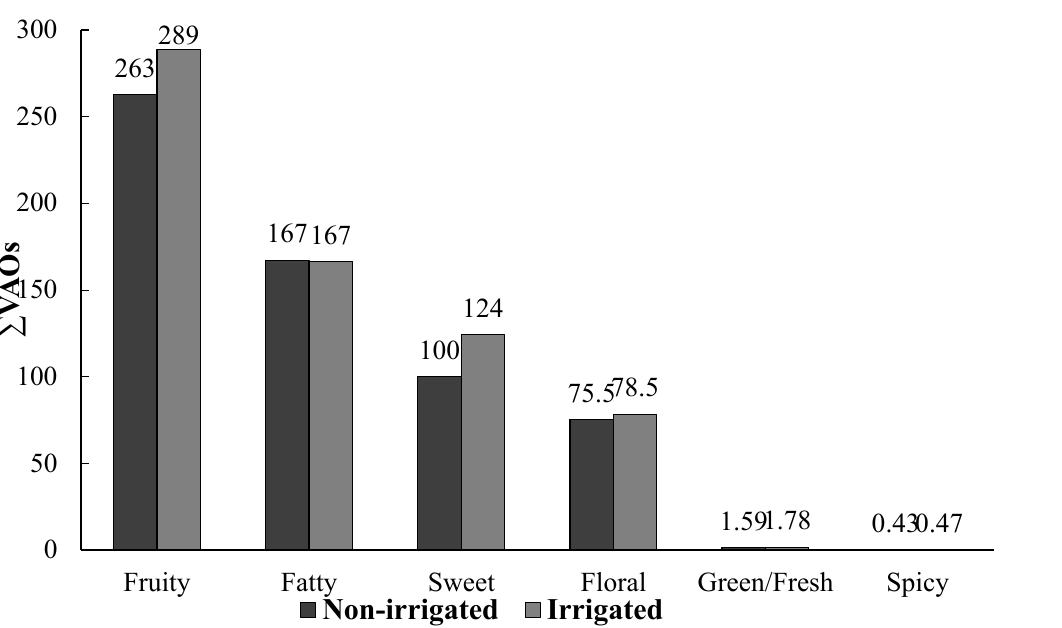
Figure 1. Aromatic series in La Mancha Chelva wines made with grapes from irrigated and non- irrigated vines ( Σ VAOs).